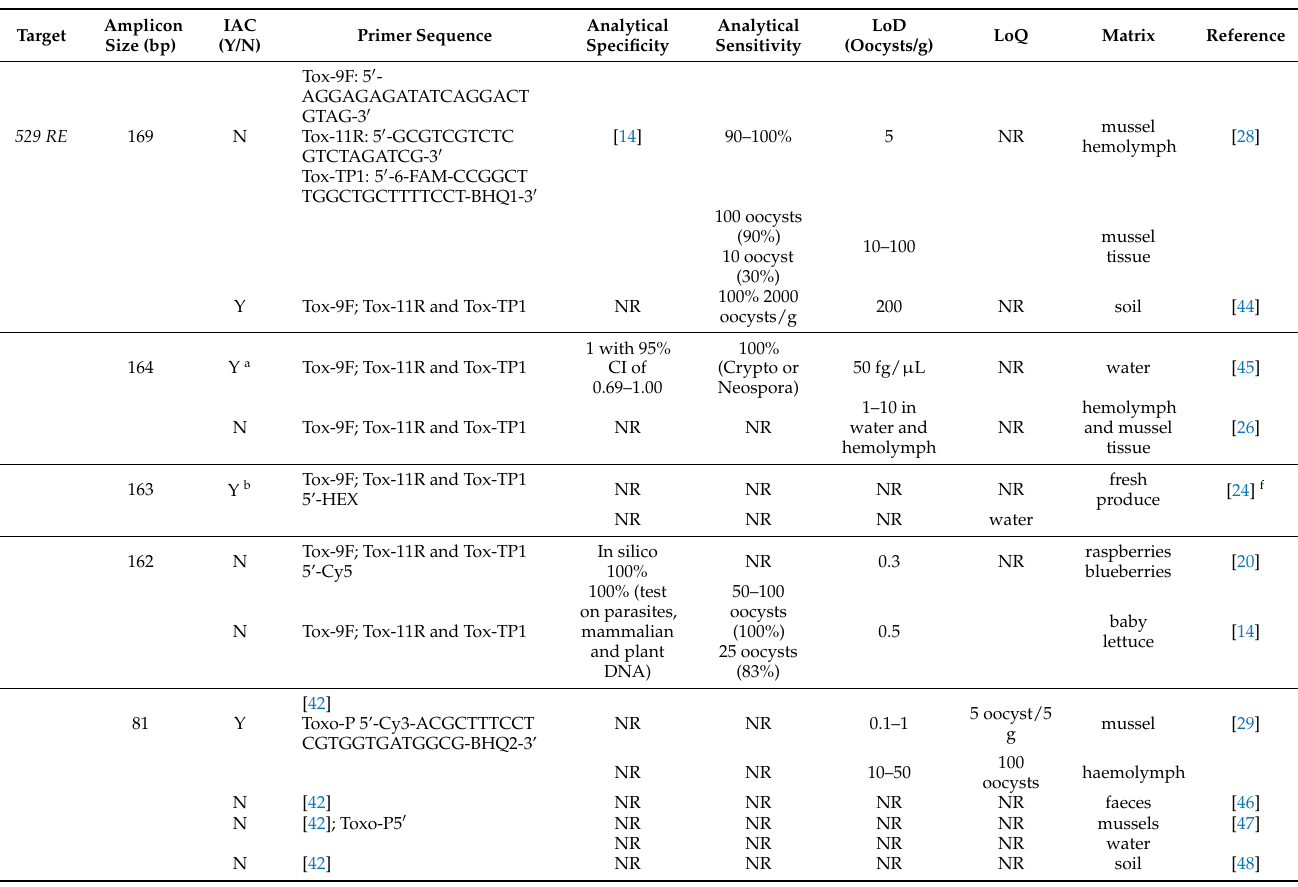
Abbreviations: HRMC = high resolution melting curve; FRET = Fluorescence Resonance Energy Transfer; MC = melting curve. Table 6. qPCR Taqman assays targeting B1 gene and 529 RE used for Toxoplasma gondii oocysts detection.